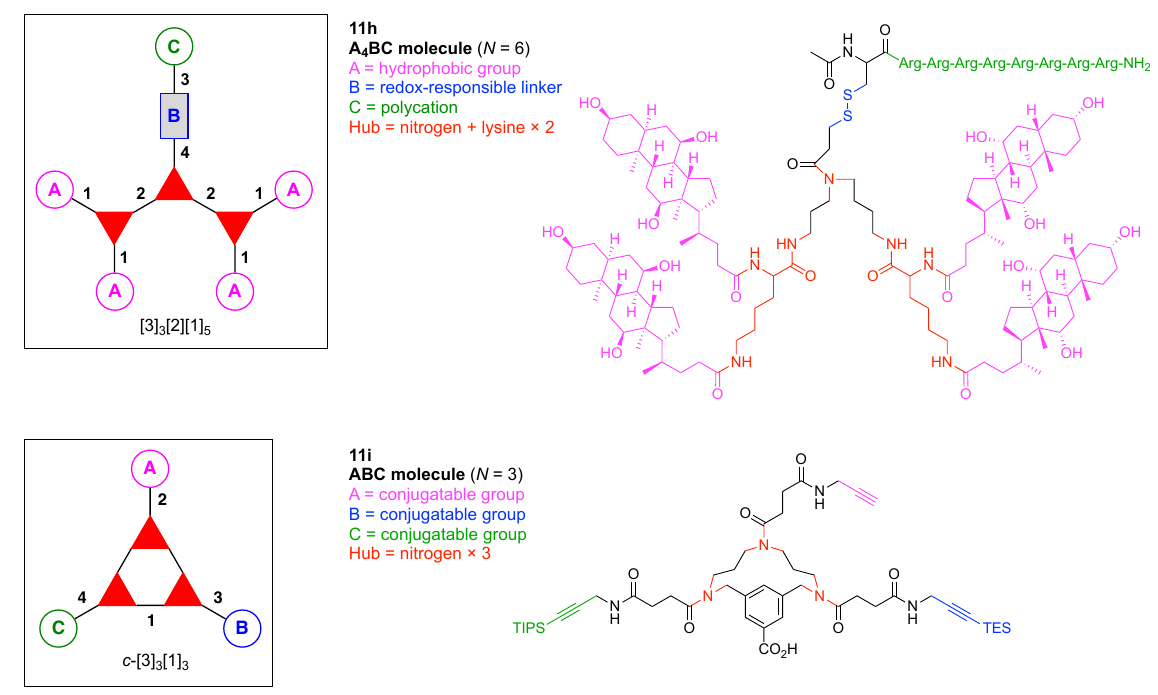
Figure 56. Two examples each containing three nitrogen hubs.